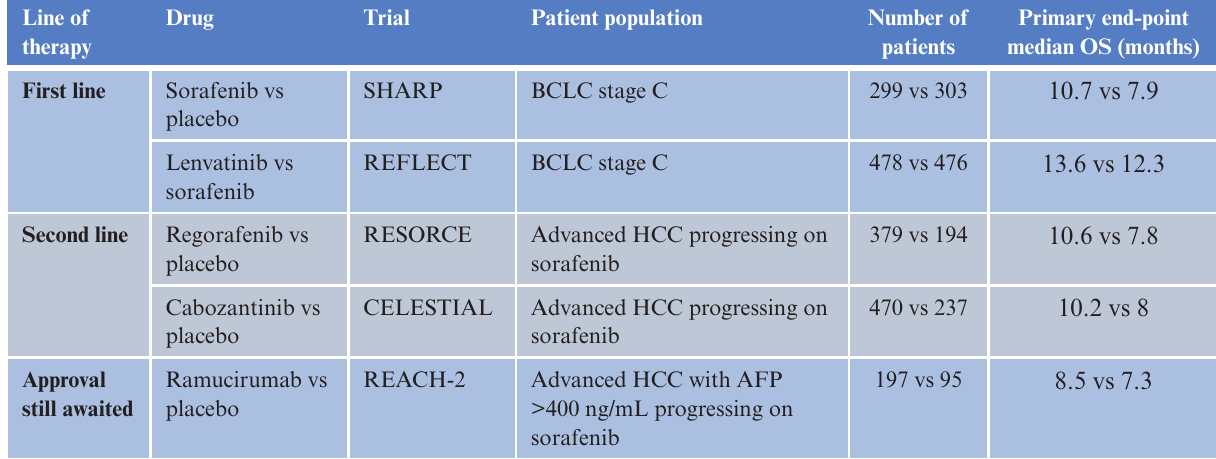
Table 1: Phase III trials in advanced BCLC stage C HCC 53-56